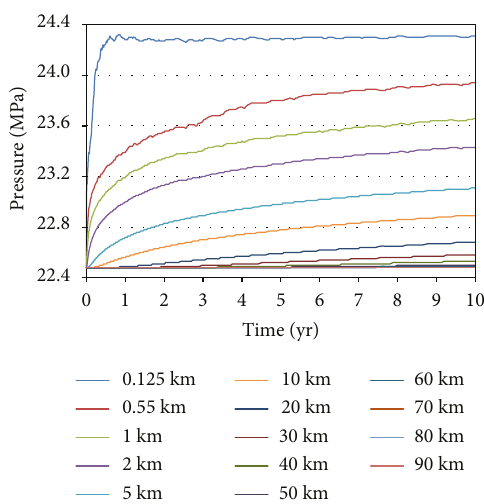
Figure 10: Pressure changes at pressure monitoring points during injection.